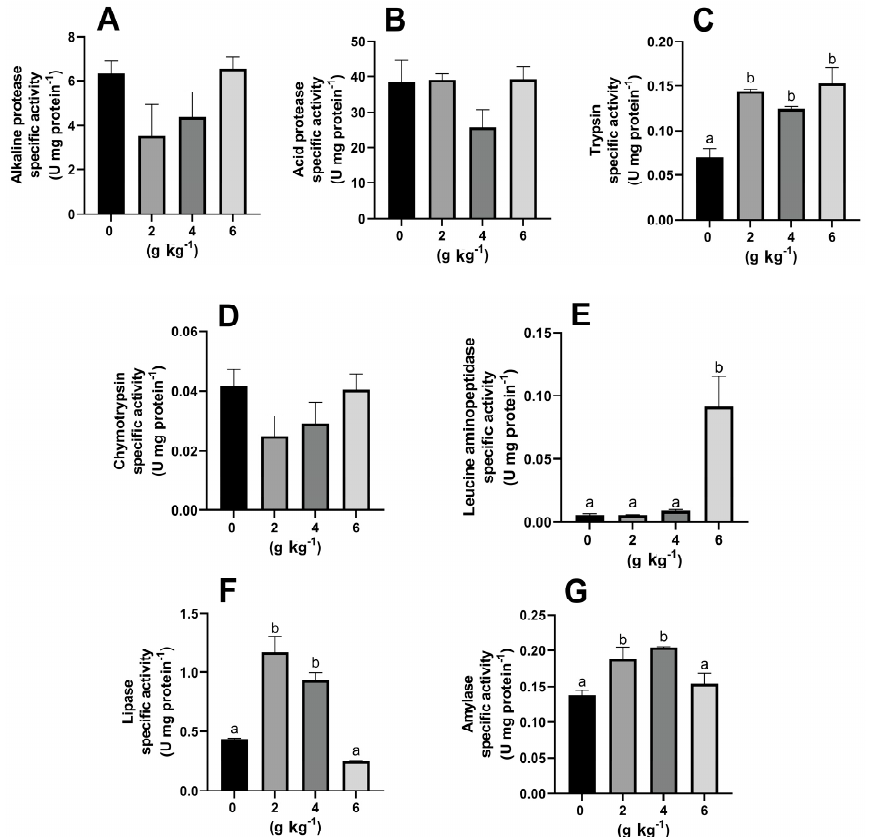
Figure 2. Effect of dietary mannan-oligosaccharides on the specific activity (U mg protein − 1 ) of digestive enzymes of A . tropicus . ( A ) Alkaline protease; ( B ) acid protease; ( C ) trypsin; ( D ) chymotrypsin; ( E ) leucine aminopeptidase; ( F ) lipase; ( G ) α -amylase. Letters above bars indicate differences between groups ( p > 0.05).